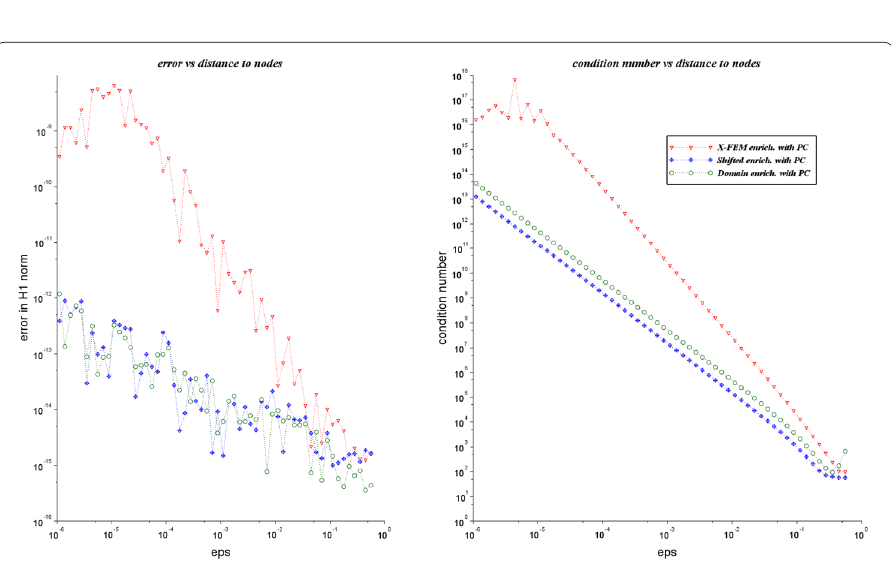
Fig. 15 The use of linear element pre-conditioners barely improves the accuracy and condition number of quadratic elements